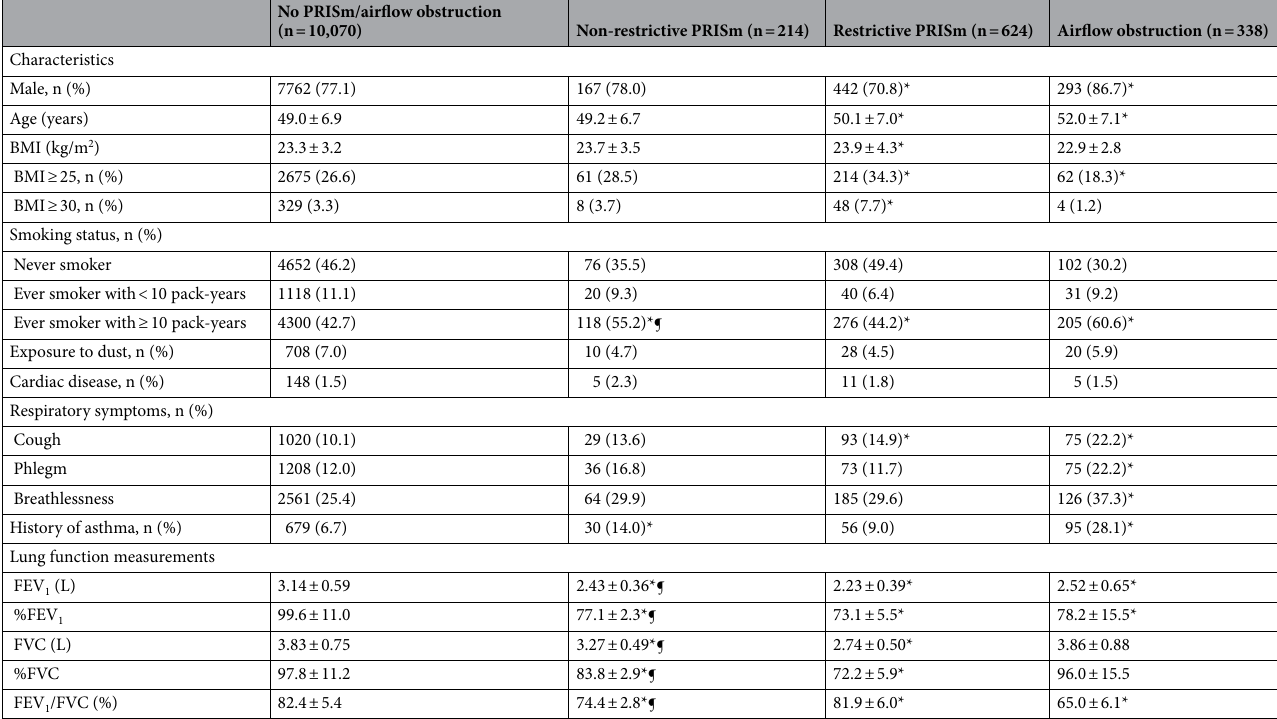
Table 1. Baseline characteristics of the participants in the cross-sectional analysis. BMI body mass index;